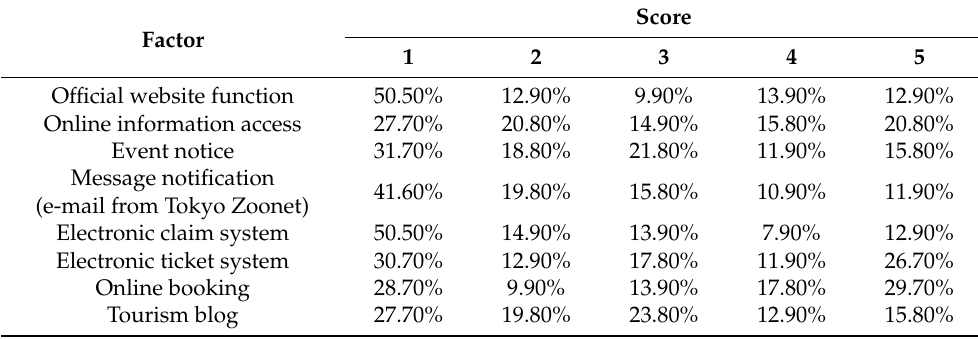
Table 10. Results (Performance) of the second-level questionnaire (Official website function).